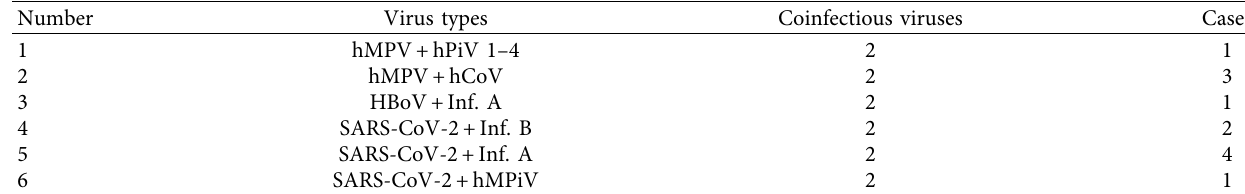
Table 4: Coinfection of SARS-CoV-2 with others respiratory viruses in flu-like symptomatic patients. Number Virus types Coinfectious